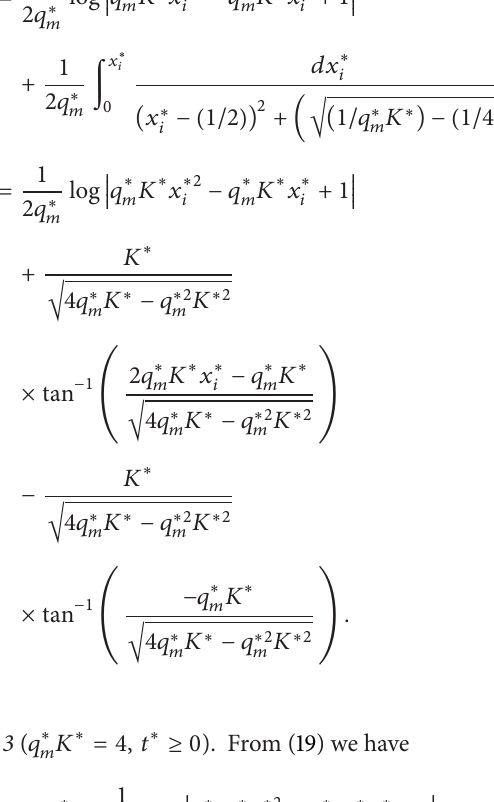
Figure 2: Interface position with